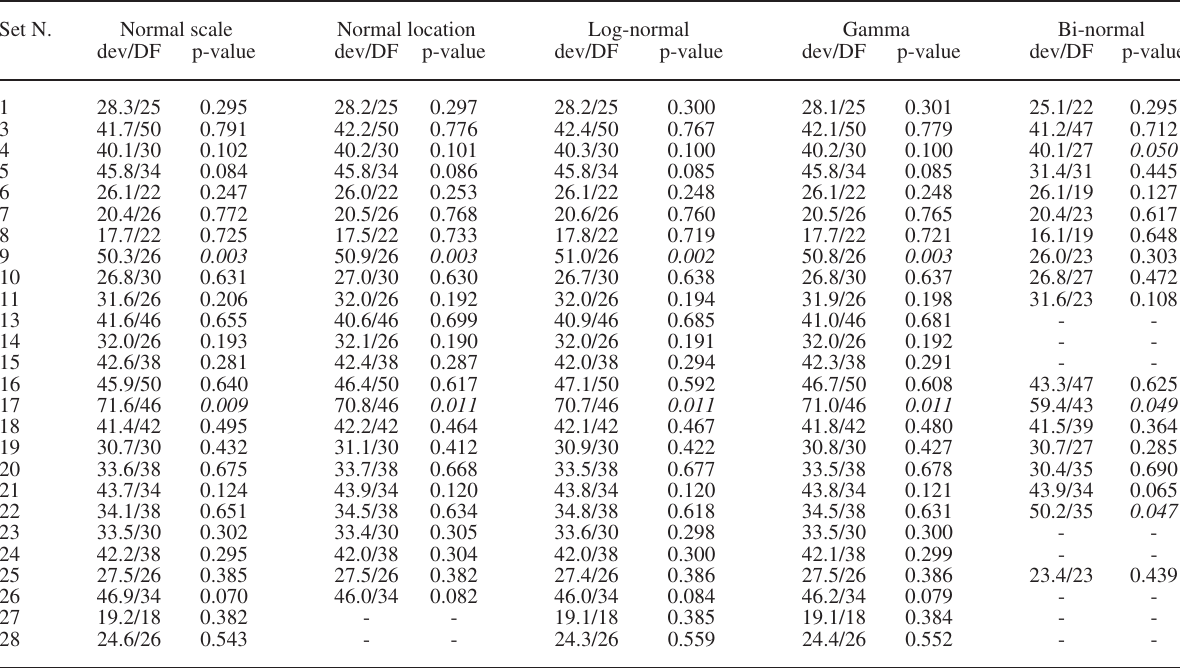
Table 5. – Model deviance for individual sets with the corresponding goodness of fit p-value. DF = degrees-of-freedom. Critical level for goodness of fit = 0.05. The significant p-values are shown in italic. Set N.